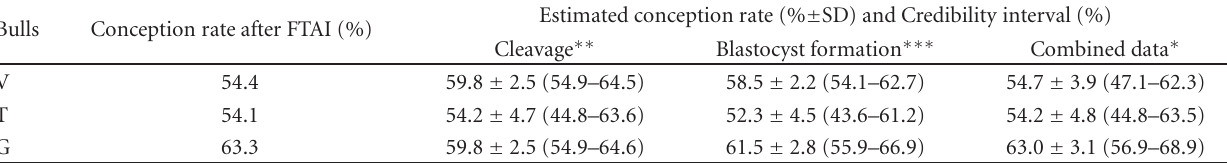
Table 2: Comparisonbetween conception rate after fixed-time artificial insemination(FTAI) and estimated fertility for each bull, established using the program Winbugs 1.4 with 95% of credibility interval, based on data from cleavage, blastocyst formation rates, and on the combined